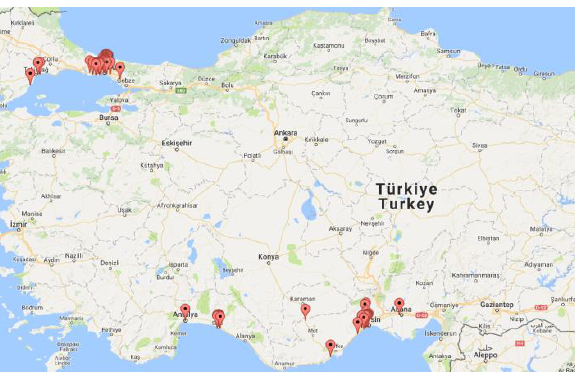
Figure 1. Visited locations of a social media user Criteria